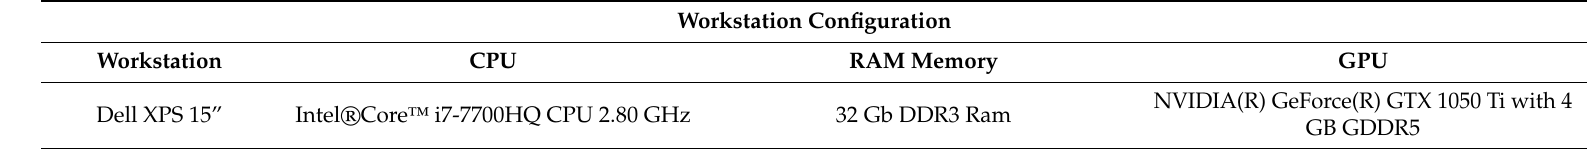
Table A1. Workstation set-up and a summary of the entire workflow time for all the monitored areas. The processing time is closely linked to the configuration of the computer and the number of collected